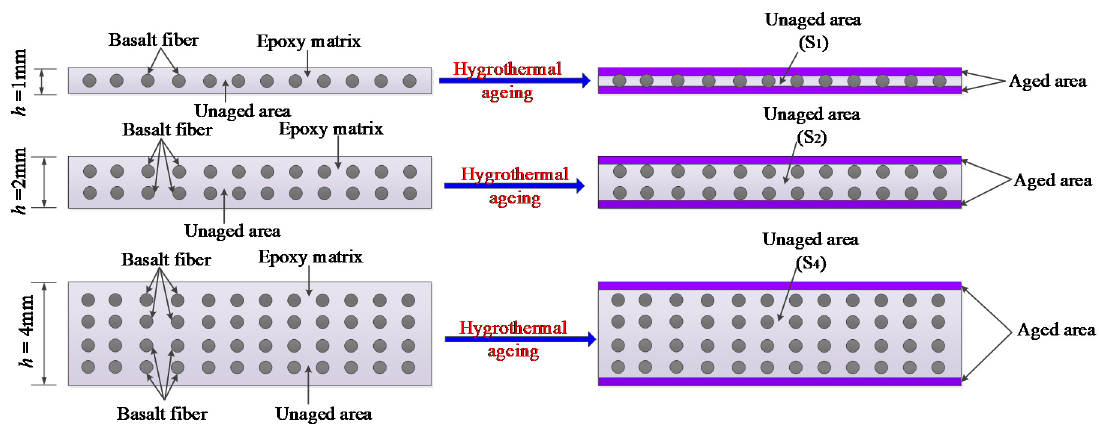
Figure 12. Schematic diagram of the ageing of the specimens with di ff erent thicknesses through cross section at a same certain ageing